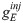
Determination of individual effective conductance in experiments.a, an image showing simultaneous dendritic and somatic recordings on a hippocampal CA1 pyramidal cell that was filled with fluorescence dye Alexa Fluor-488. b, schematic diagram of the recording configuration when a pyramidal neuron receives an individual E input. A voltage clamp is made at the soma and a dynamic clamp is made on the dendritic trunk about 100 μm away from the soma. Somatic voltage is clamped from −90 mV to −50 mV when an individual E input is given by dynamic clamp on the dendrite. The local E conductance takes the form proportional to e−t/5 − e−t/7.8 (time unit: ms) with a peak amplitude of 2.5 nS. c, gEinj obtained as Isyninj/(εE-V) by least square fitting of a double exponential function. d, schematic diagram of the recording configuration when a pyramidal neuron receives an individual I input—same as in b except that the local I conductance takes the form proportional to e−t/6 − e−t/18 (time unit: ms) with a peak amplitude of 4 nS. e, gIinj obtained as Isyninj/(εI-V) by least square fitting of a double exponential function (cf. c for color coding). Not shown is the case for the clamp voltage at the absolute reversal potential of −70 mV (see text). f, I-V relations corresponding to E (red) and I (blue) inputs under the five holding voltage levels, respectively. The data are collected at the time 10 ms after the onset of the stimulus. The value of the voltage shown in the abscissa is relative to the resting potential. g, the relation between the conductance determined from the slope (Eq 2) and the intercept (Eq 3). The E and I conductances are marked by red and blue color, respectively. Each dot corresponds to the conductance value at one time point. The red and blue lines are corresponding linear fitting. For reference, the black reference line has a slope of unity. h, the independence of the I conductance value on the change of the I reversal potential. The circles on the left and right columns are the peak I conductances determined with the I reversal potential EGABAA=-70mV and EGABAA=-80mV, respectively. The solid lines link the conductances determined at the same neuron. The mean relative change of the conductance under different reversal potentials is within 5%.